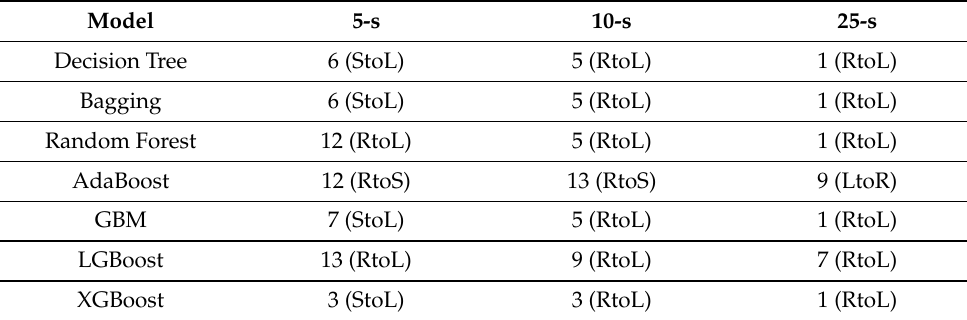
Table 9. Best transition matrix feature rank using tree-based importance.